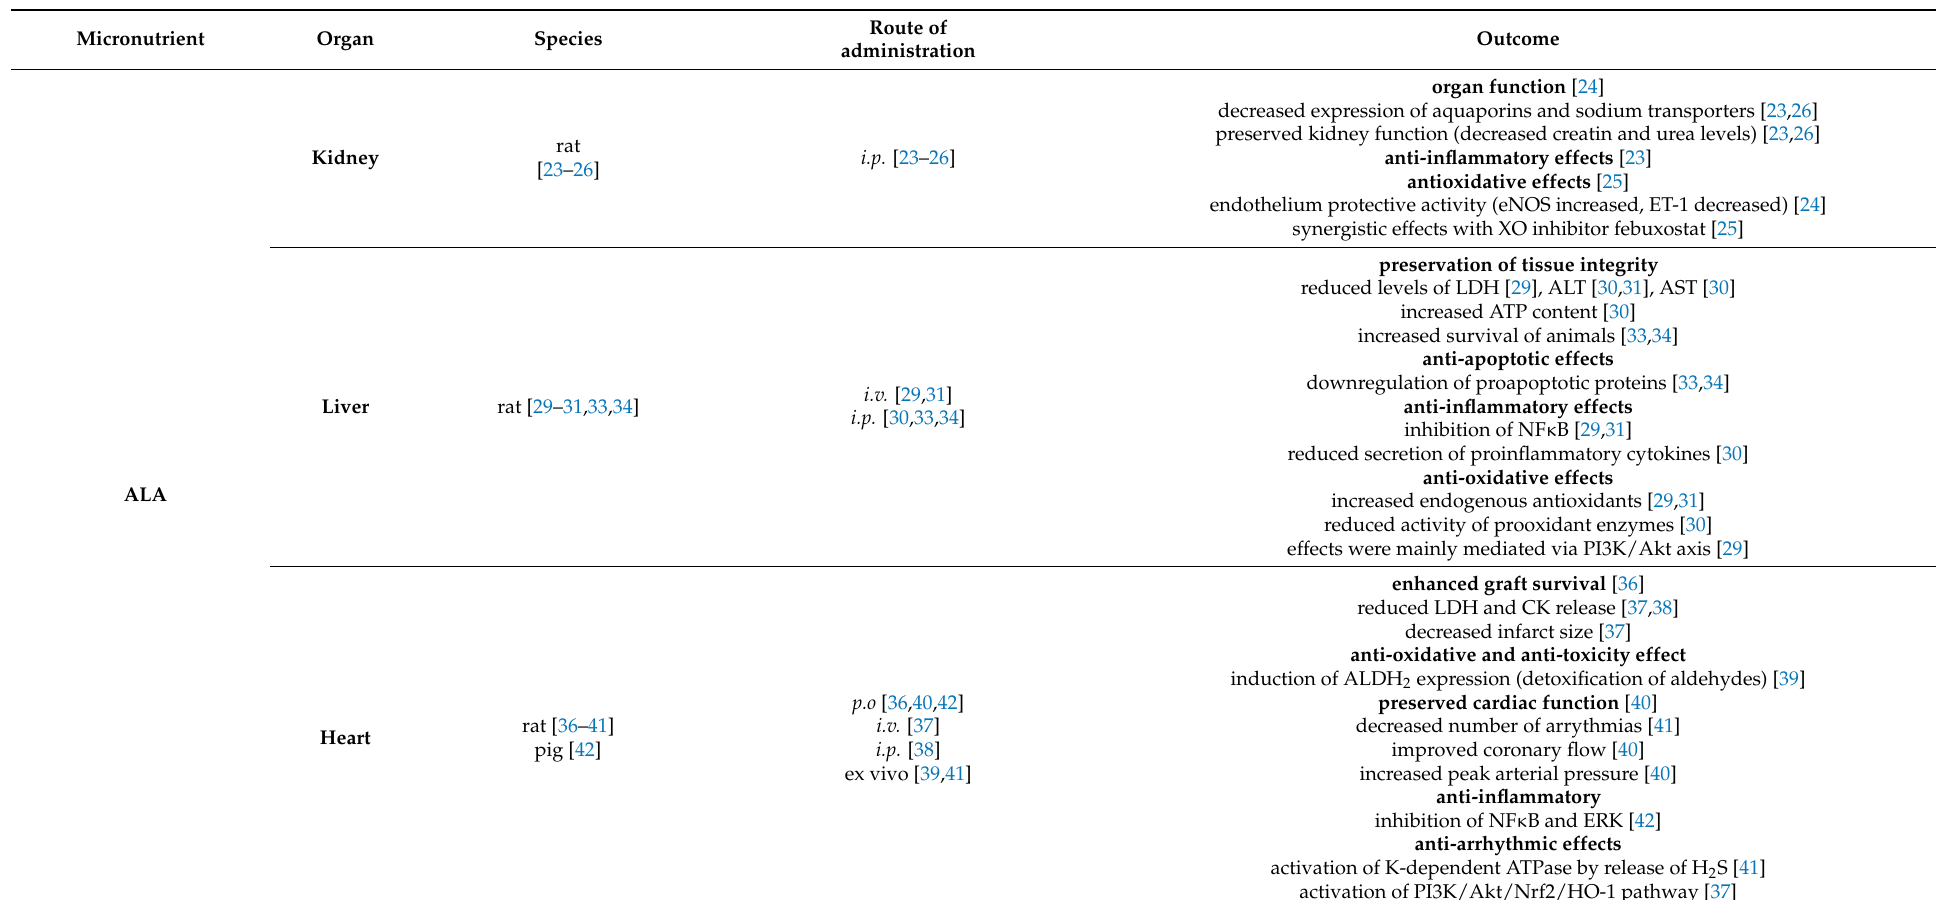
Table 2. Summary of the main preclinical findings of the respective micronutrients with reference to the individual organs. Main categories of outcomes are presented in bold.